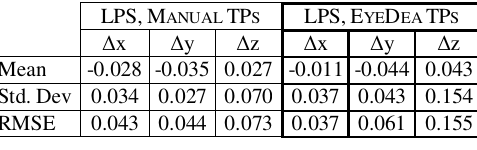
Table 6. Statistics of CPs residuals [m]